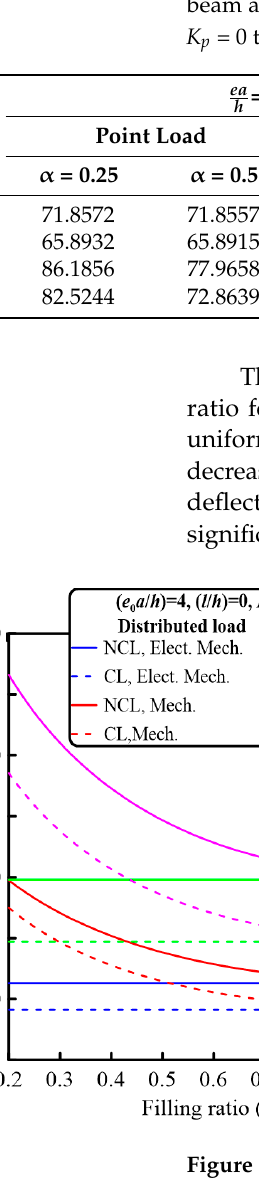
Table 4. The relative percentage difference in the transverse deflection, ( % D ∆ max ) increasing the nondimensional elastic foundation parameter Kp for electromechanical and mechanical nonclassical and classical behaviors for different values of filling ratio and nonclassical parameters under point and uniformly distributed loads at perforation filling ratio, α = 0.25 and 0.5, at N = 4 and